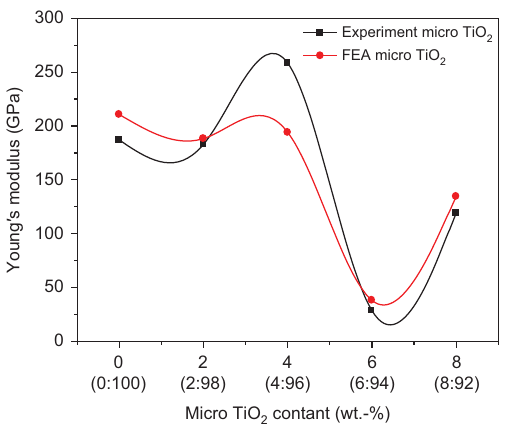
Figure 5 Effect of micro-TiO A384 alloy composites.